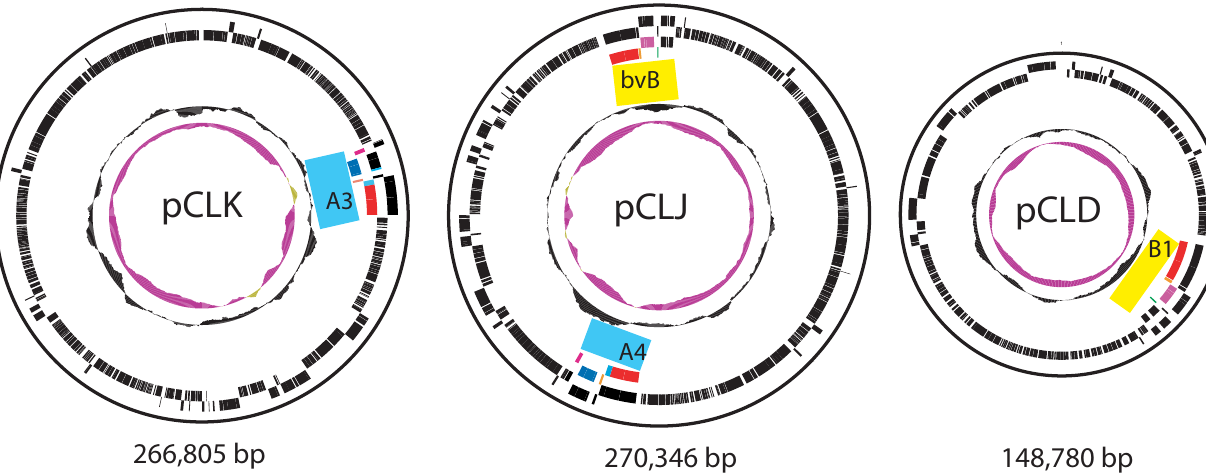
Figure 3. Circular plasmid maps of pCLK (Loch Maree), pCLJ (657), and pCLD (okra) . These plasmid maps show the location of the neurotoxin gene complexes within each of the plasmids and the predicted sites of gene transcription. The 266,805 bp pCLK contains the BoNT/A3 gene, the 270,346 bp pCLJ contains both the BoNT/A4 and BoNT/bvB genes separated by about 97 kb and the 148,780 bp pCLD contains the BoNT/B1 gene. The data are described from the outermost circle to the innermost circle. Circles 1 and 2 show black bars to indicate predicted coding sequences on the plus strand (circle 1) and minus strand (circle 2). Circle 3 and 4 indicate the BoNT cluster genes transcribed on the plus strand and minus strand respectively. The colors used in circle 3 and 4 are the same as shown in Figure 1: NTNH and BoNT genes are red, orfX1, orfX2, orfX3 are dark blue, p47 is light blue, HA70, HA17 and HA33 are light purple and botR is orange. Circle 5 depicts the G + C content and the innermost purple circle shows the GC skew (G 2 C/G + C) with tan values . 1 and purple ,